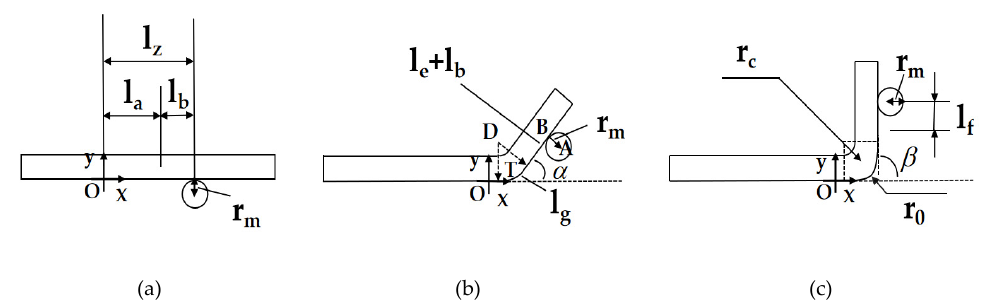
Figure 9. Schematic diagram of bending process: ( a ) Initial state of bending. ( b ) During bending. ( c ) After bending.